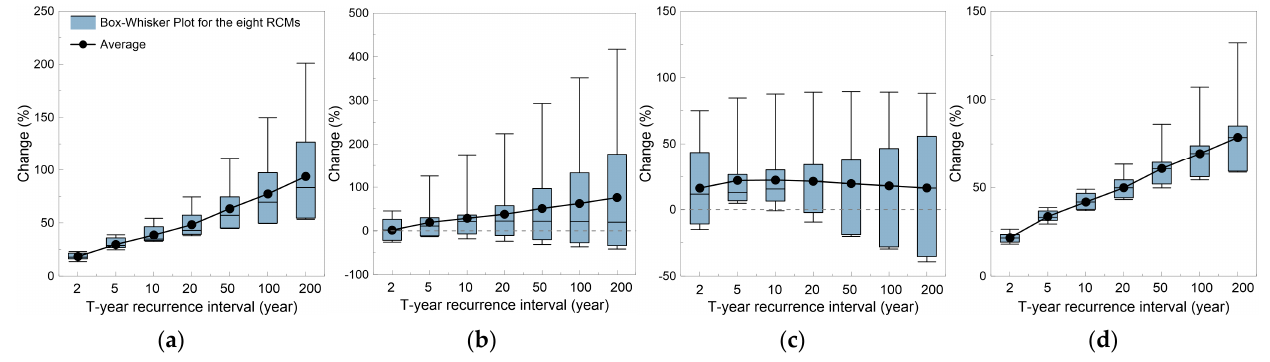
Figure 11. Change rate (%) of the future (2021–2050) T-year rainfall quantile based on the RTD- NSRPM method. ( a ) Ulsan, ( b ) Busan, ( c ) Changwon, and ( d ) Miryang.